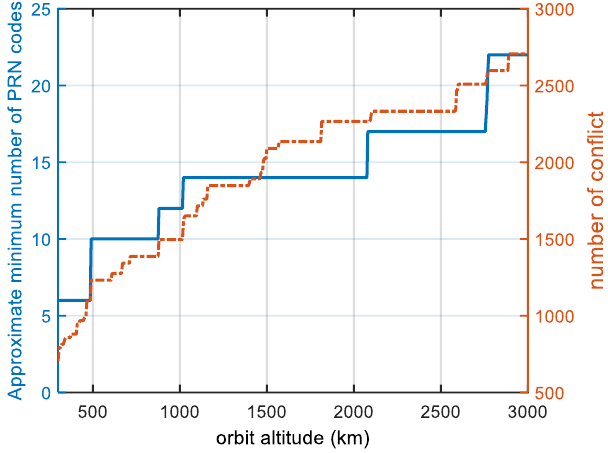
Figure 10. Graph of the orbital altitude and approximate minimum number of PRN codes. The blue line shows the approximate minimum number of PRN codes, and the orange line shows the number of conflicts. This is a polar-orbiting constellation at low altitudes of 300–3000 km, which is divided into 6 orbits with 11 satellites each. The number of conflicts is equal to the number of instances of 1 in the conflict matrix R .